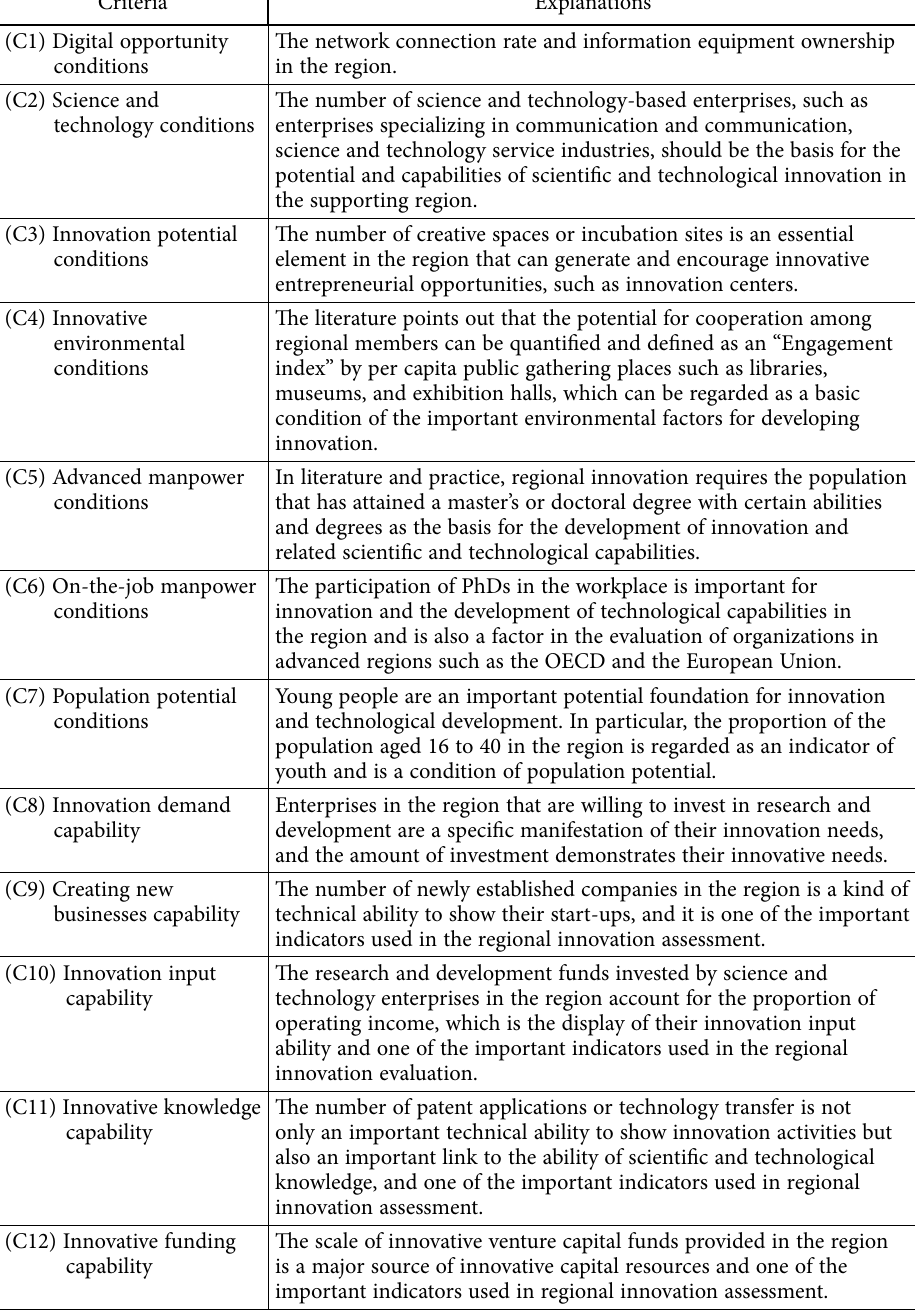
Table 1. Explanations of RIS evaluation